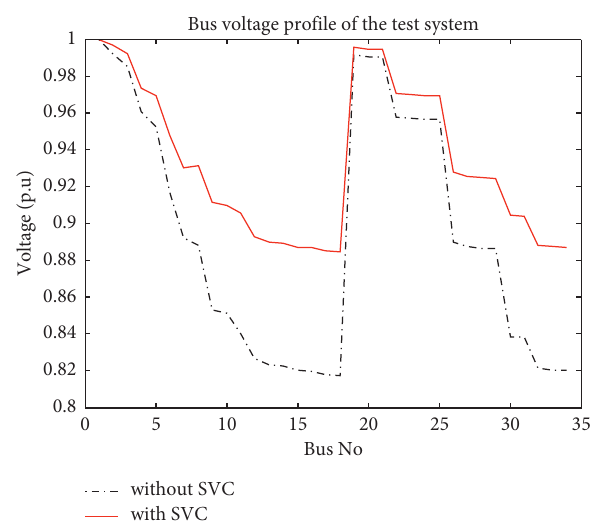
Figure 4: Voltage profile with and without SVC using PSO.